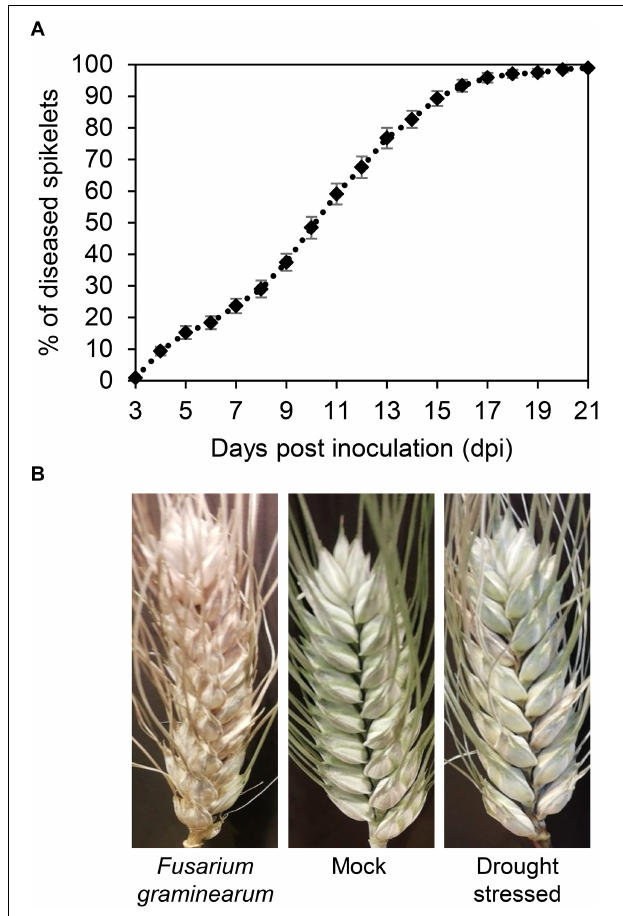
FIGURE 6 | Box-plots of (A) spike temperatures ( ◦ C) and (B) photosynthetic efficiencies (F v /F m ) of Triticum turgidum (cv. Marco Aurelio) plants subjected to mock (M), drought stress (DS) and Fusarium graminearum artificial inoculation (24, 48, and 72 hours post inoculation (hpi)) treatments during the greenhouse experiments. The data was derived from the averages and standard errors of three treatments ( F. graminearum -inoculated, drought-stressed, and mock) with at least 20 plants for each, and three independent experiments for each treatment. Different letters refer to the statistical analysis performed using one-way analysis of variance (ANOVA) with the Tukey’s honest significant difference (HSD) post hoc test at 0.99 confidence level and p <